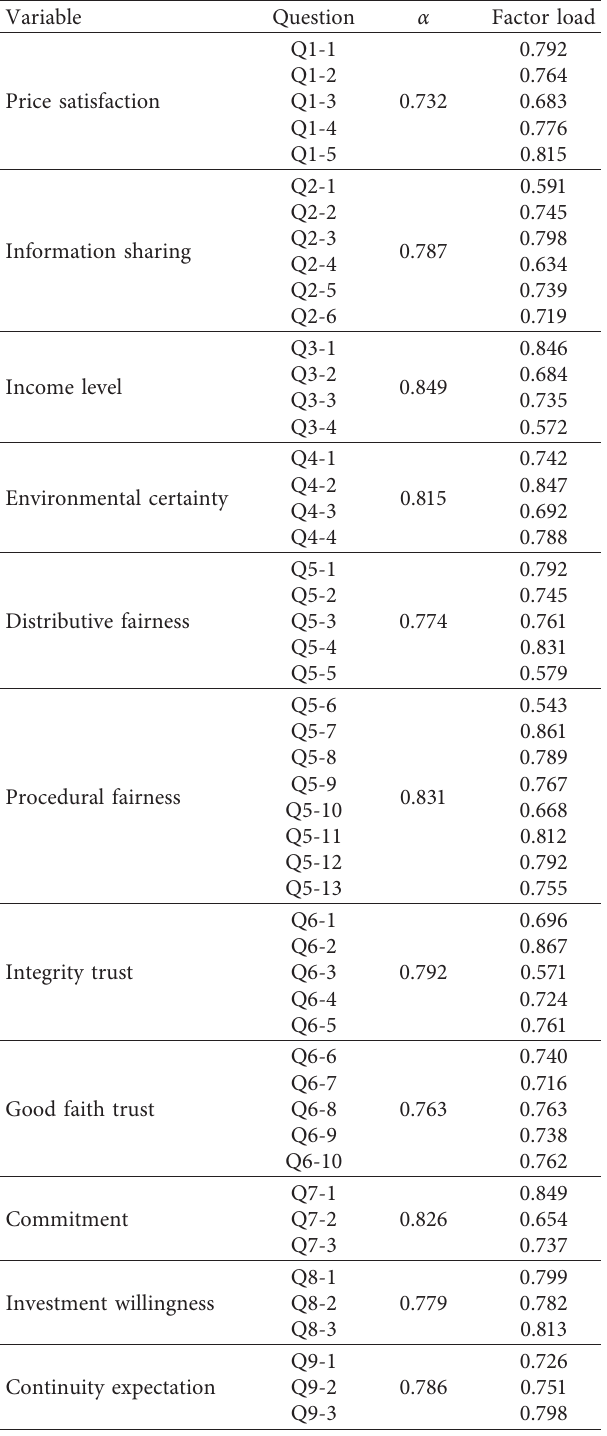
Table 1: Reliability and validity analysis of